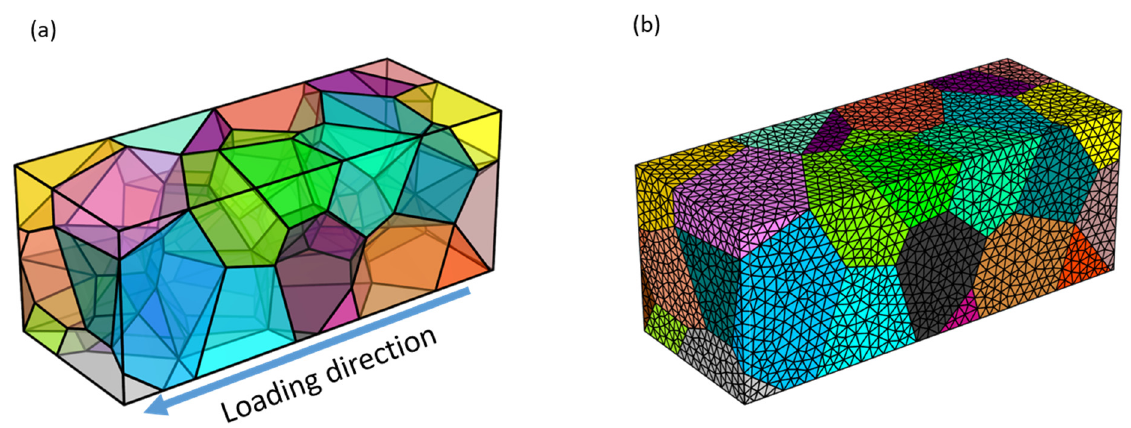
Figure 2. ( a ) Polycrystalline model with 49 grains generated by NEPER and ( b ) meshed equivalent for finite element analysis.